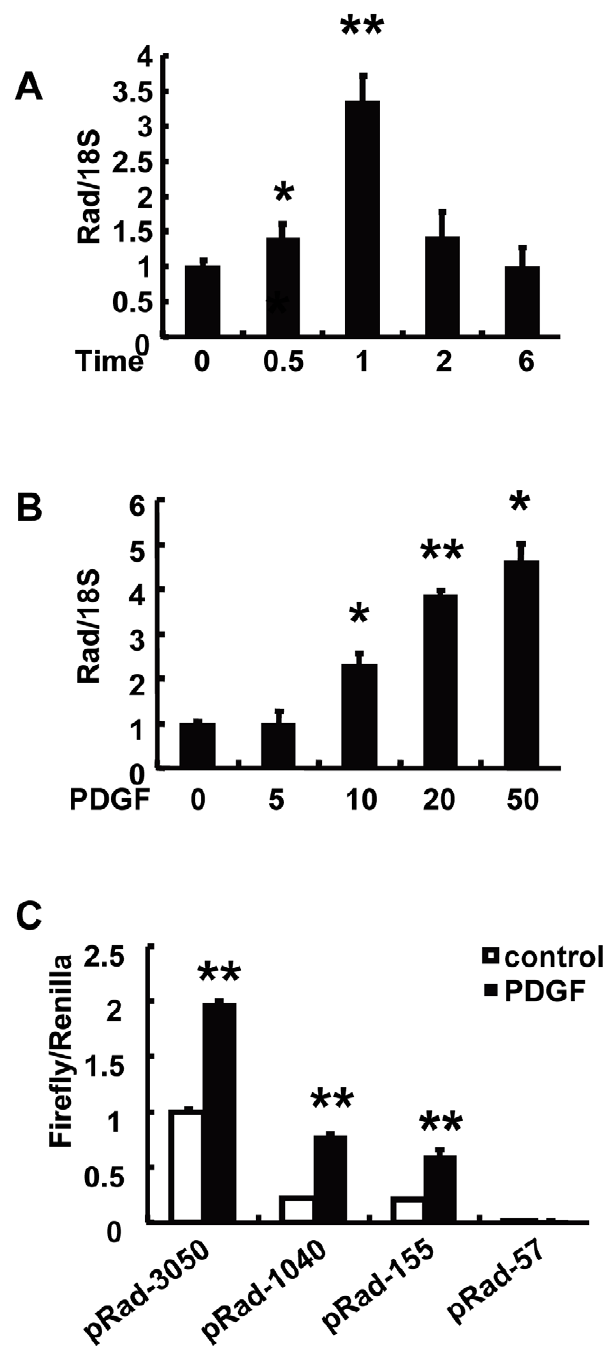
Figure 1. PDGF induces Rad expression in RASMCs. (A) Time course of Rad expression level in RASMCs after 20 ng/ml PDGF-BB treatment. (B) Dose-response of Rad expression after 1 hour treatment with the indicated concentrations of PDGF-BB. Rad expression was detected by real-time PCR and normalized by 18S (n=3, * p , 0.05, ** p , 0.01). (C) Responses of different Rad promoter reporters to PDGF- BB stimulation in RASMCs (n=4, ** p , 0.01).